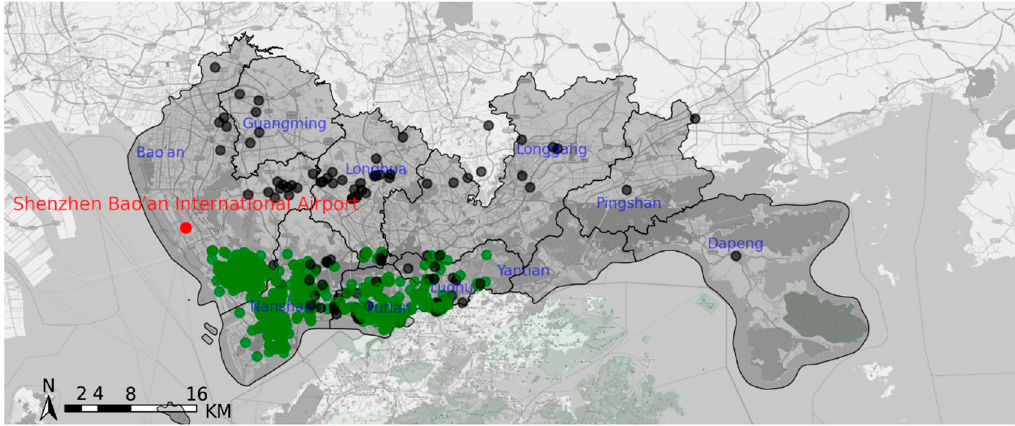
Figure 9. Distribution of potential demand points for FB in Shenzhen airport.